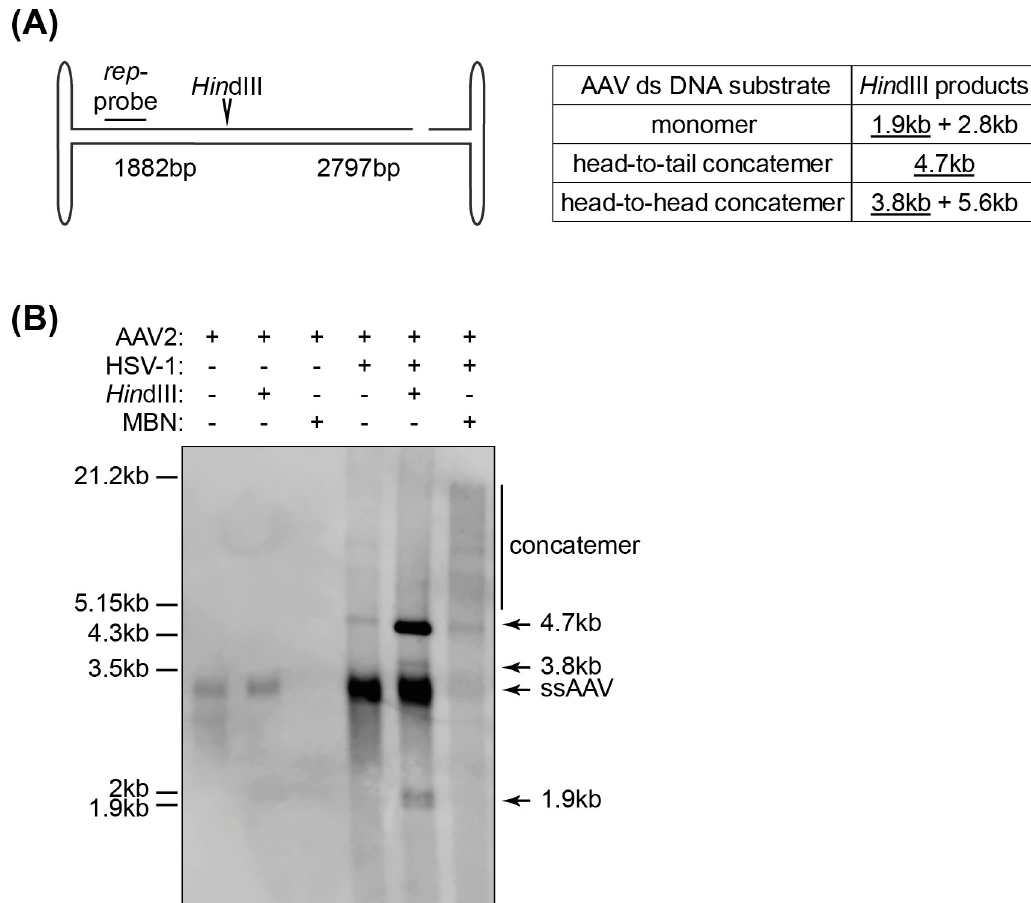
Fig 3. Southern analysis of AAV2 DNA. (A) Schematic representation of the AAV2 genome with the Hin dIII restriction site and the rep- probe binding site indicated. The table on the right shows the expected sizes of the fragments upon Hin dIII treatment with the fragment containing the rep- probe binding site underlined. (B) Southern blot of Hirt DNA extracted at 12 hpi from BJ cells infected with AAV2 alone (gcp/ cell = 20’000) or co-infected with AAV2 (gcp/ cell = 20’000) and HSV-1 (pfu/cell = 1) showing untreated, Hin dIII digested or mung bean nuclease (MBN) treated